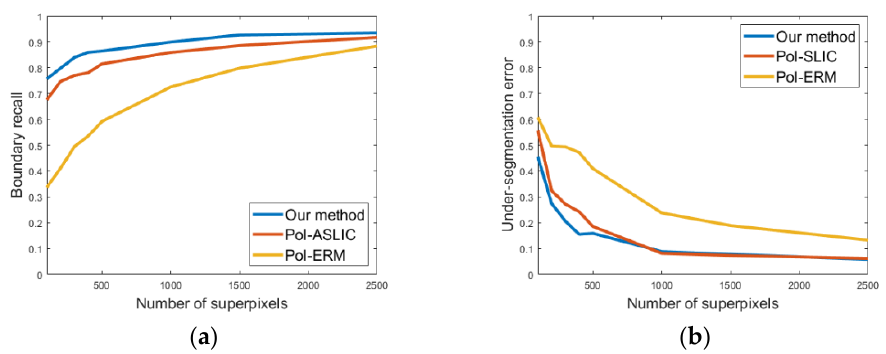
Figure 10. Numerical evaluation of superpixel segmentation performance based on AIRSAR data. ( a ) Boundary recall; ( b ) under-segmentation error.